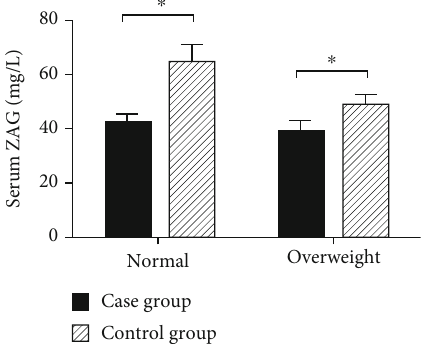
Figure 2: Comparison of serum ZAG levels between the overweight and normal groups in the case group and control